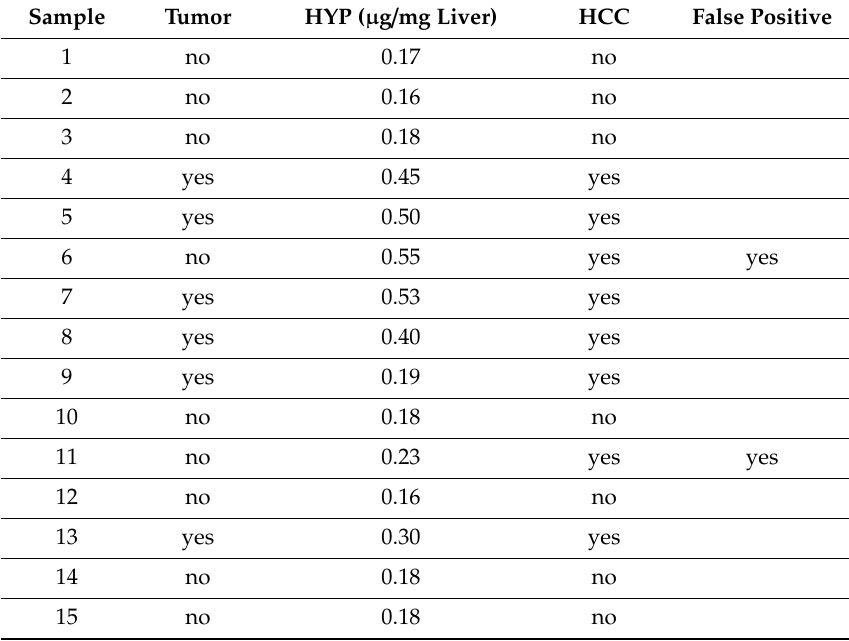
Table 1. Evaluation of liver biopsy hydroxyproline as a diagnostic for HCC in NASH. Of the 15 livers comprising the test set, 9 were free of HCC and 6 were HCC-positive. Use of liver biopsy hydroxyproline as a diagnostic yielded and accuracy of 87%. Two livers were deemed HCC-positive when in fact they were not. Sample Tumor HYP ( µ g / mg Liver) HCC False Positive